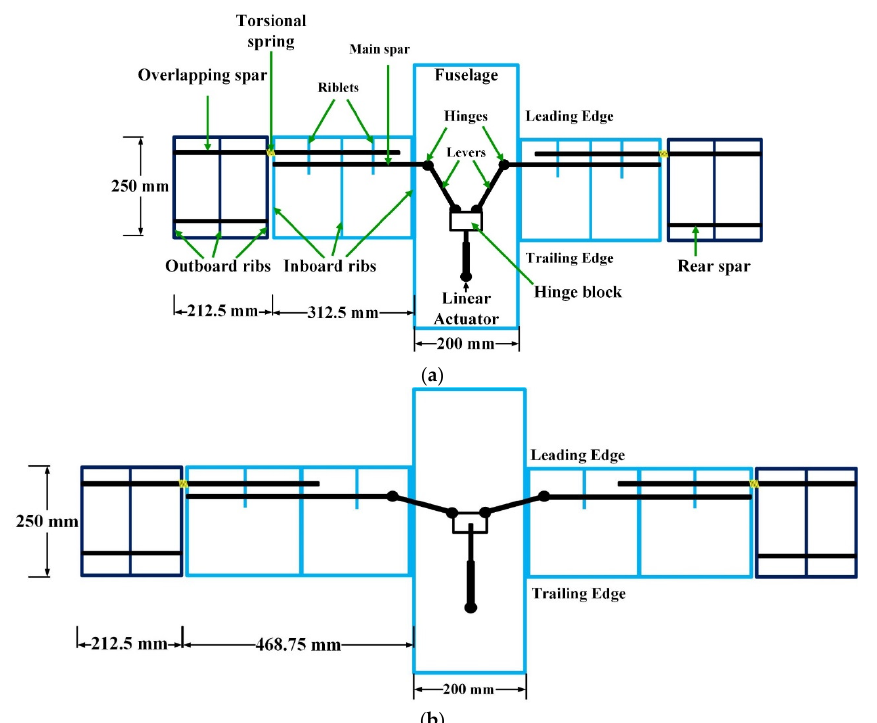
Figure 2. Schematic (top-view) of the ASAPP wing concept: ( a ) Before span extension. ( b ) After span extension. The inboard segment consists of a main spar that can translate in the spanwise direc- tion. The segment is covered by flexible elastomeric skin (latex) to maintain the aerody- namic profile of the wing. To minimize the out-of-plane deformation of the skin, three ribs along with two riblets are used to support the skin (as shown in Figure 3). Before morph- ing, the span of the inboard segment is 312.5 mm, whilst that of the outboard segment is 212.5 mm, as shown in Figure 2. Keeping a larger segment for inboard span extension induces less strain in the latex skin at maximum extension compared with when using a smaller segment. The root rib is fixed to the walls of the fuselage whilst the middle rib and the riblets can slide on the main spar to allow the skin to stretch uniformly using linear plain bearings. The tip rib (of the inboard segment) is fixed to the end of the main spar, and the flexible skin is attached to it. As the spar translates in the spanwise direction, the tip rib moves with it, causing the skin to stretch. The main spars are made from Aluminum and are connected to the fuselage using Aluminum rails. They are located at 30% of the chord and they have a hollow square cross-section to prevent sliding ribs from rotating around them (Figure 3). Rails are used to transfer the loads from the spars to the fuselage; in addition, they prevent chordwise movement of the main spars. Span extension actua- tion is achieved by a linear actuator placed in the fuselage along its longitudinal direction. The actuator is connected to the main spars using levers, hinges, and a hinge block, as shown in Figures 2 and 3. It should be noted that only one linear actuator is required because ASAPP is capable only of symmetric span extension.